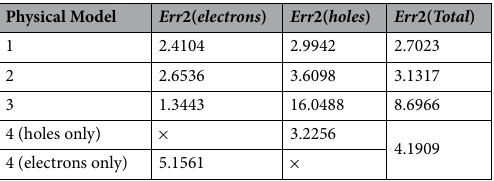
Table 6. Relative Error (in %) for the four different physical